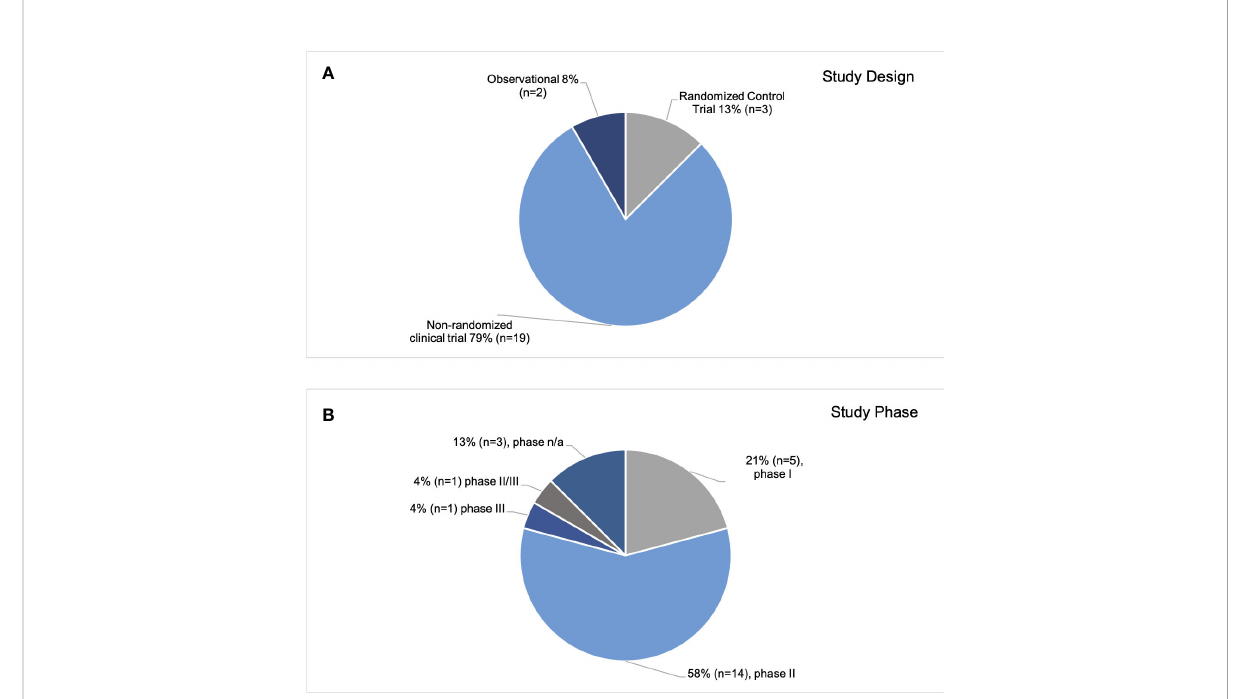
FIGURE 2 Study Design and Phase. Breakdown of analyzed trials by study design (A) and phase (B)